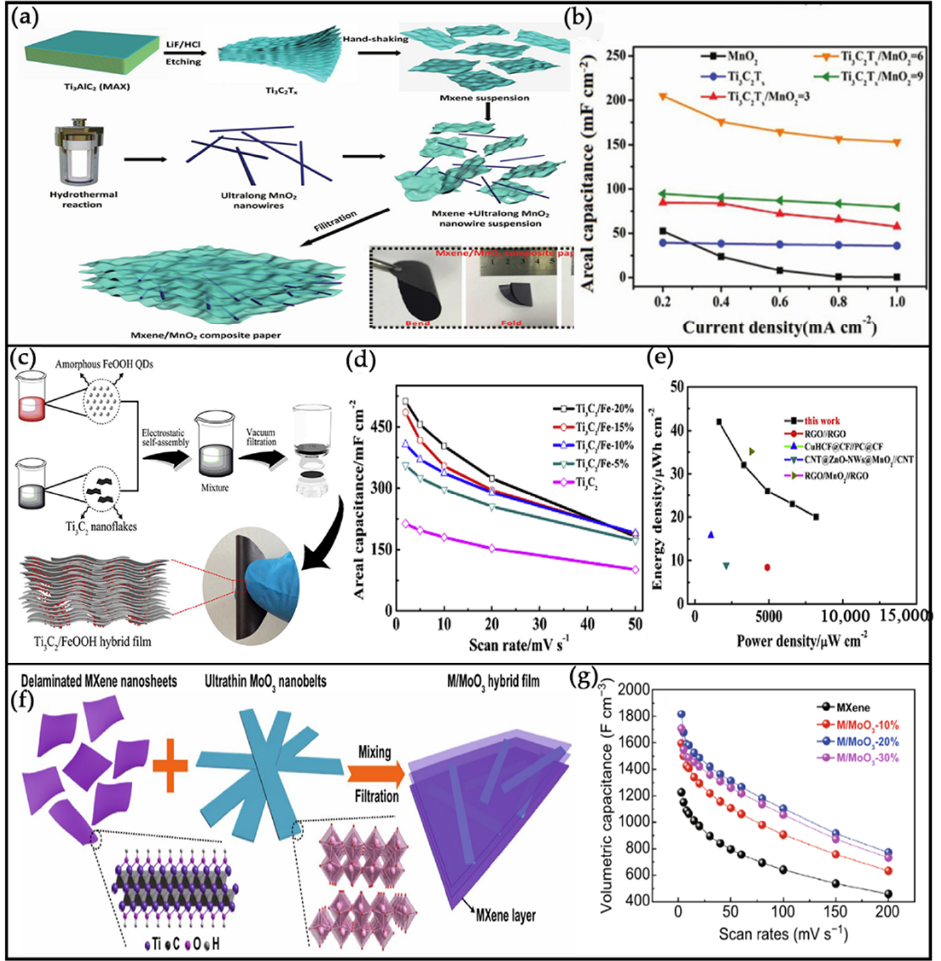
Figure 11. ( a ) A schematic representation of the fabrication process. ( b ) Specific areal capacitance